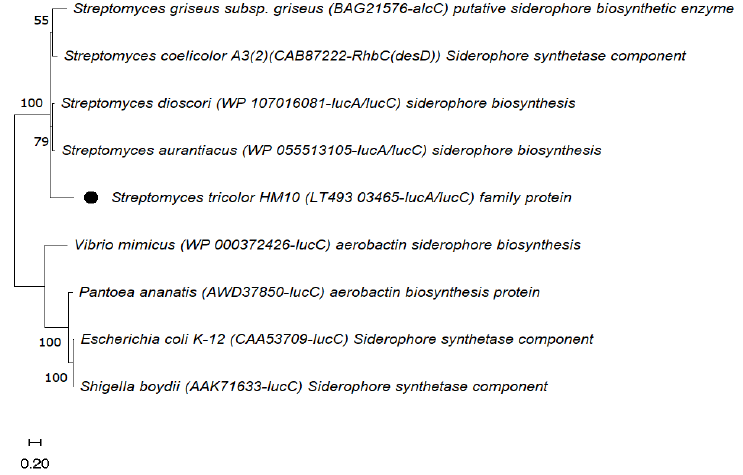
Figure 7. Molecular phylogenetic analysis of IucA/IucC family protein in the hydroximate pathway compared with eight protein sequences from other bacteria. The dendrogram was generated by the maximum likelihood, Jones–Taylor–Thornton (JTT) model, and nearest-neighbor-interchange (NNI) with 1000 bootstrap replicates (see the Methods section). The accession numbers of the SidC FASTA sequences are given.